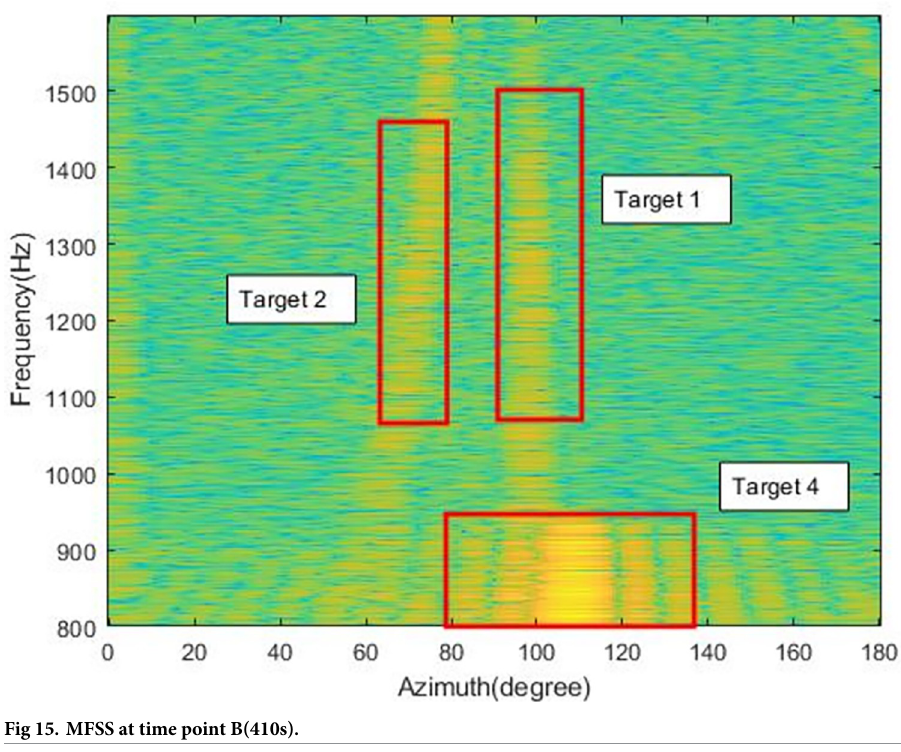
Fig 15. MFSS at time point B(410s).